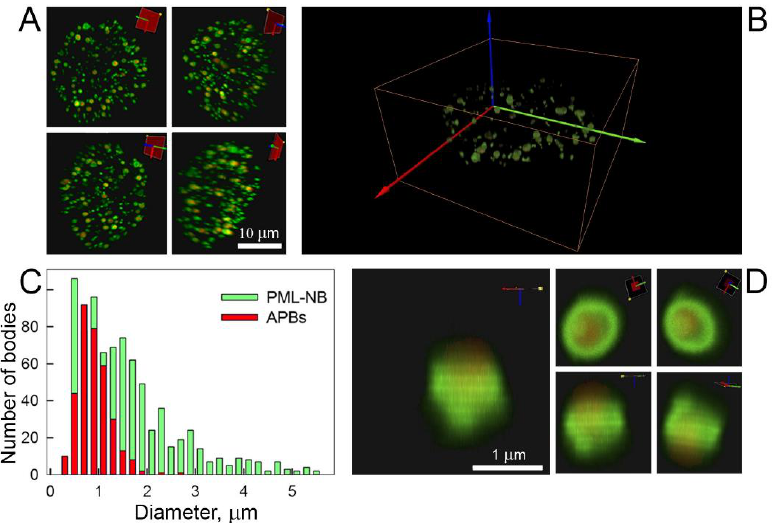
Figure 3. PML-bodies associated with alternative telomere lengthening (APBs). ( A ) Image of APBs with co-expressed by EGFP-PML-III and TagRFP-TRF1 using confocal fluorescence microscopy. Presented by APB in four angles. ( B ) 3D-structure of APBs with co-expressed by EGFP-PML-III and TagRFP-TRF1 using confocal fluorescence microscopy (see Video in Figure 2S, Panel B). ( C ) Size distribution of PML-bodies colocalized with TRF1 in U2OS cells. ( D ) Visualization using fluorescence confocal microscopy of EGFP and TagRFP of the distribution of PML and TRF1 with coexpression of EGFP-PML-III and TagRFP-TRFP1 in U2OS cells (see Video in Figure 2S, Panel B).